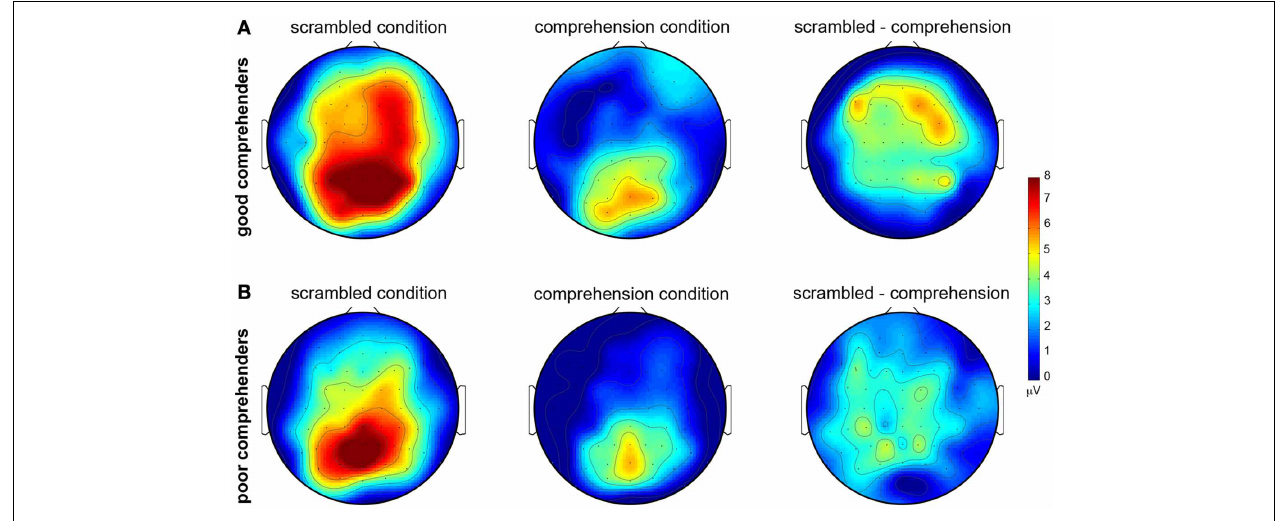
FIGURE A2 | Topographic maps of mean ERPs (non-CSD- transformed) during 400–500ms post-target-word-onset in the scrambled and comprehension conditions. (A) For good comprehenders. (B) For poor comprehenders. Warmer colors